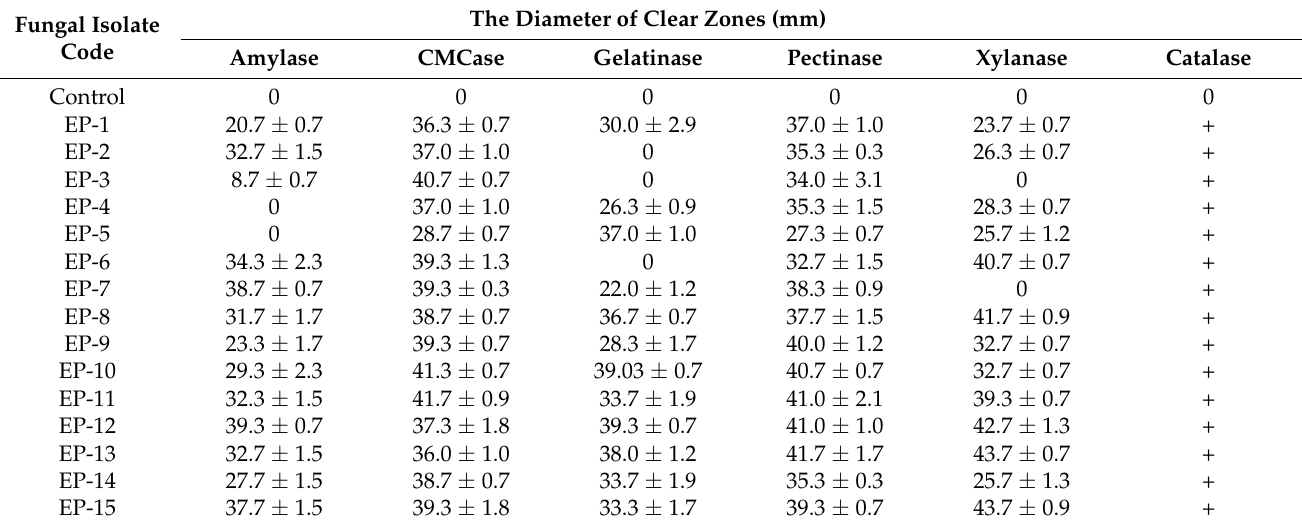
Table 2. Enzymatic activities of endophytic fungi obtained from E.